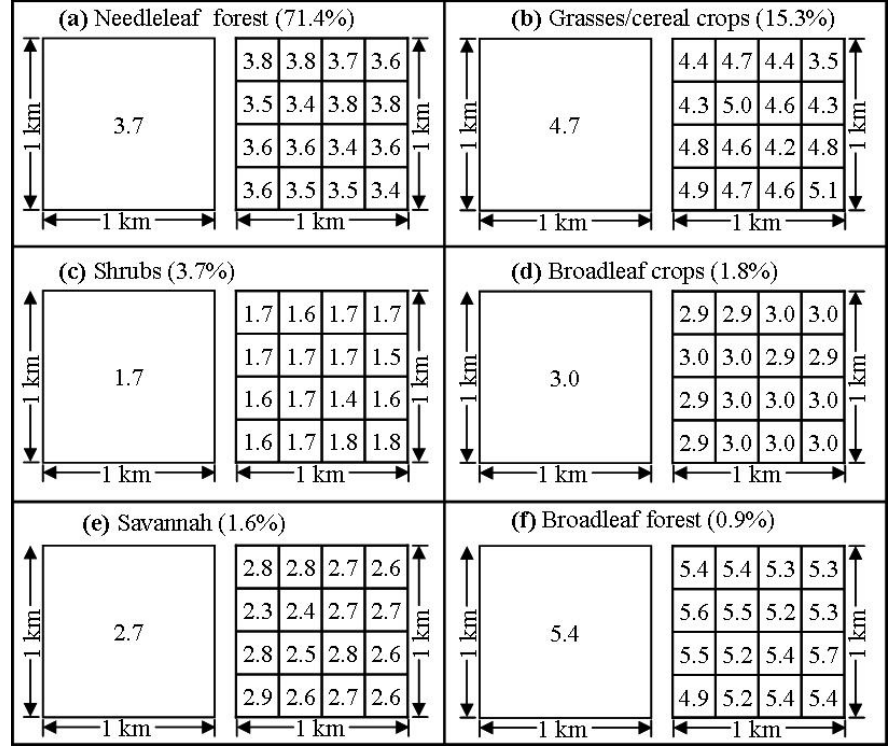
Figure 5. Comparison of LAI values at 1-km resolution without data fusion (left panel) and at 250-m resolution with data fusion (right panel) for various landcover types identified in Figure 1, including (a) needleleaf forests (comprising 71.4% of the study area), (b)